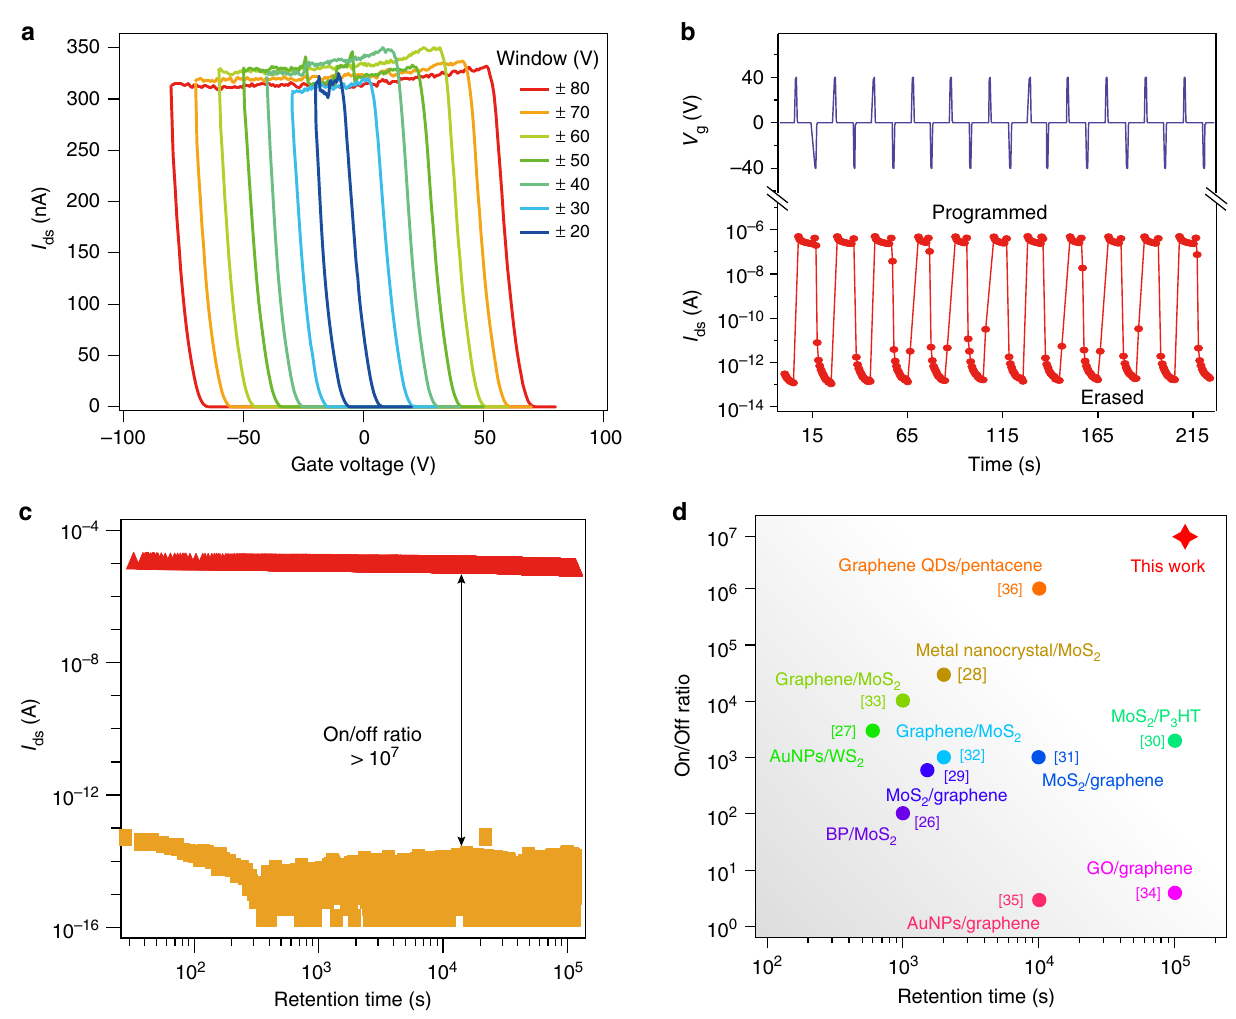
Fig. 4 Comparison of the fl oating gate memory performance of GaTe with other 2D materials. a Memory windows measured in y direction. b Demonstration of erasing and programming pulses measured in y direction. c Retention time test of the device at on and off states. d Summary of the performance of FGM made by 2D materials. Data in a , b are measured in sample S6, and data in c , d are measured in sample S4. V ds = 2 V was used in the above